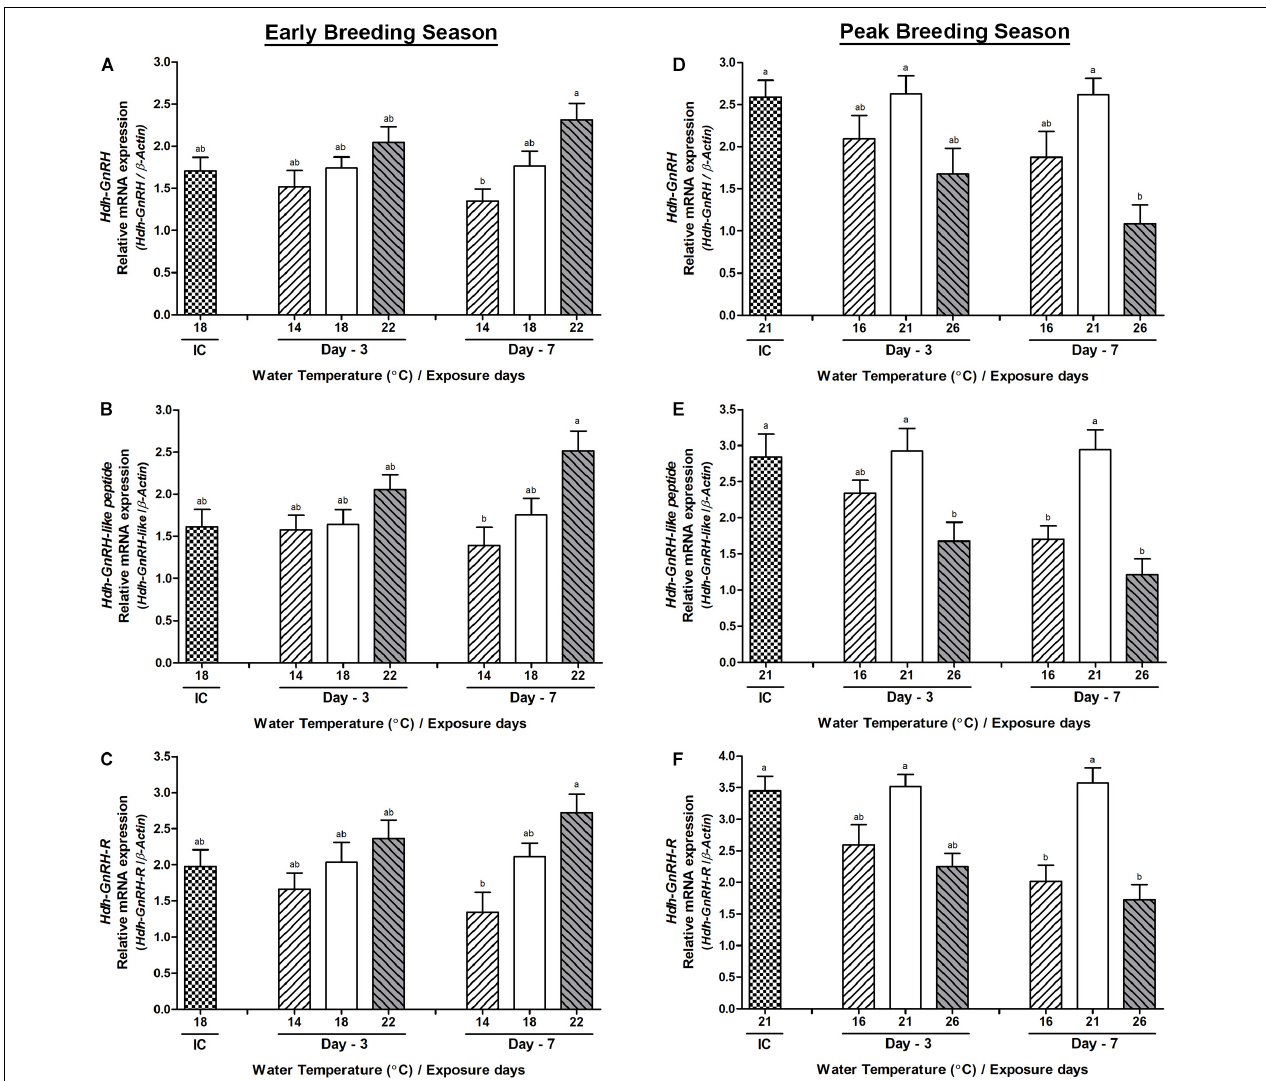
FIGURE 6 | Changes in the relative mRNA expression of Hdh-GnRH (A,D) , Hdh-GnRH-like peptide (B,E) , and Hdh-GnRH-R (C,F) in the testis of male Pacific abalone during early and peak breeding seasons after exposure to thermal stress for 7 days. Before exposure to the target temperature of thermal stress, abalone were sampled to obtain reference values that served as initial control (IC). Values represent the mean ± SD ( n = 10). Different letters on the bar indicate significant differences among different temperature groups ( p <